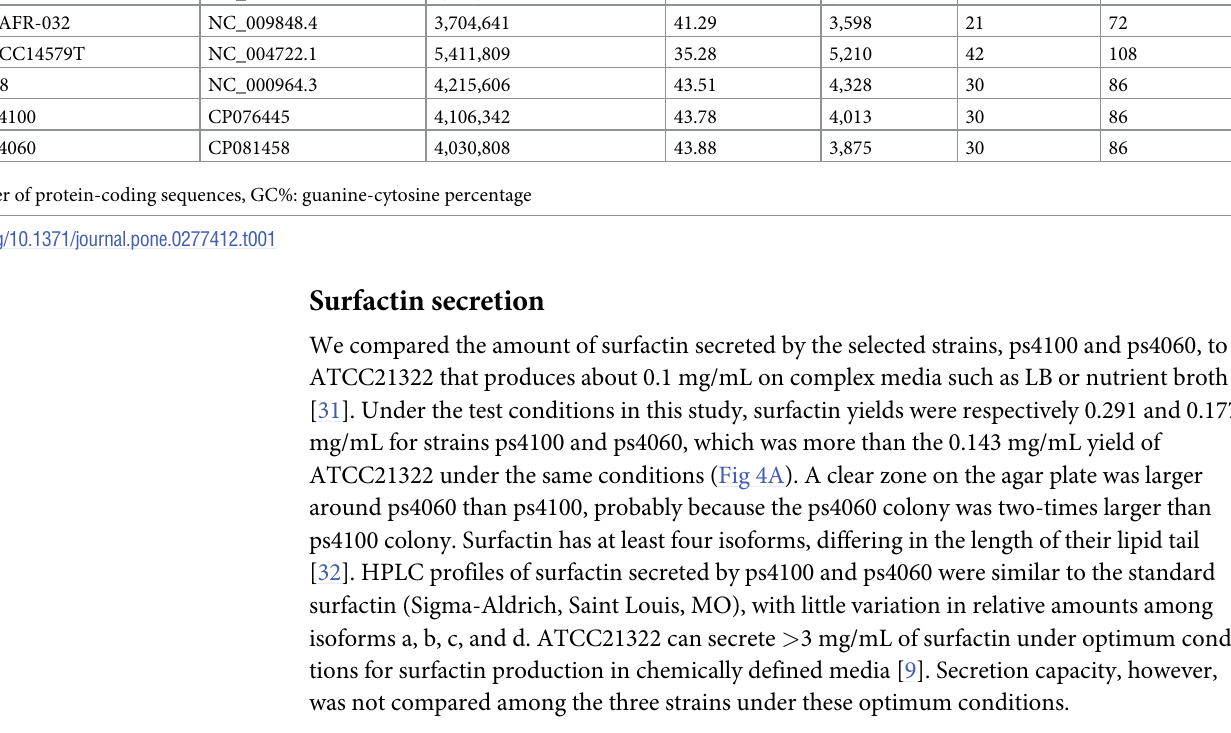
Table 2. Genome comparisons among B . subtilis strains on the same node with ps4100 and ps4060.